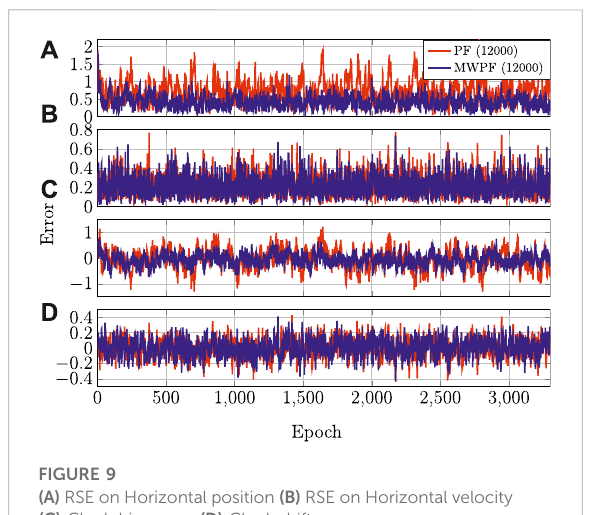
FIGURE 9 (A) RSE on Horizontal position (B) RSE on Horizontal velocity (C) Clock bias error (D) Clock drift